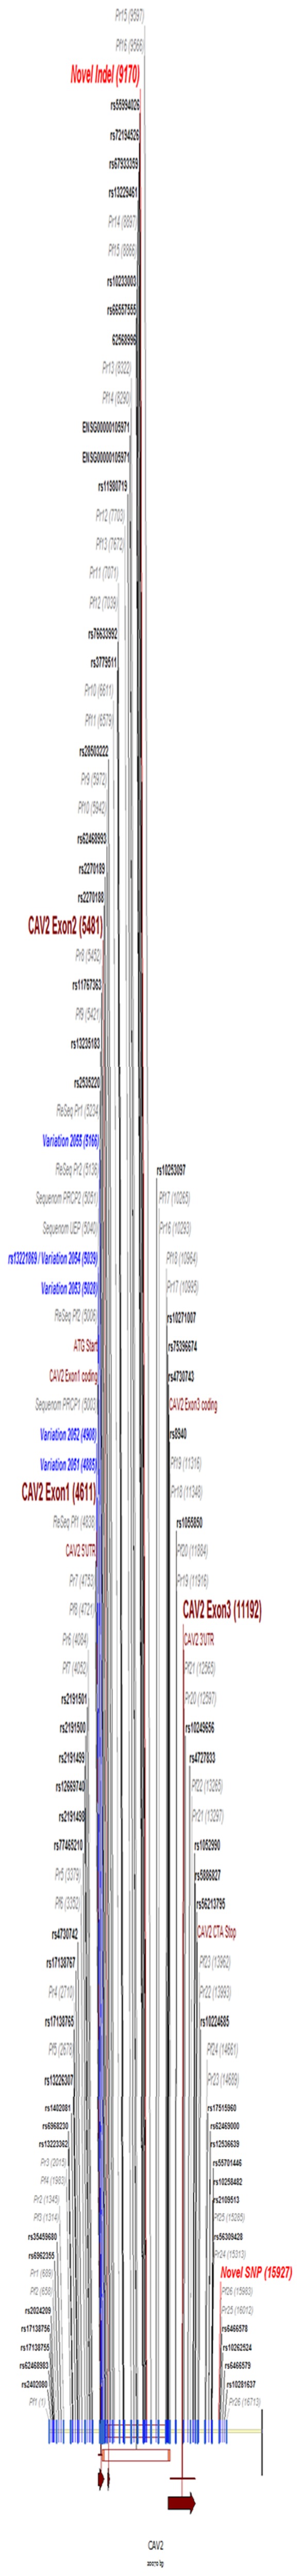
Schematic diagram of CAV2.